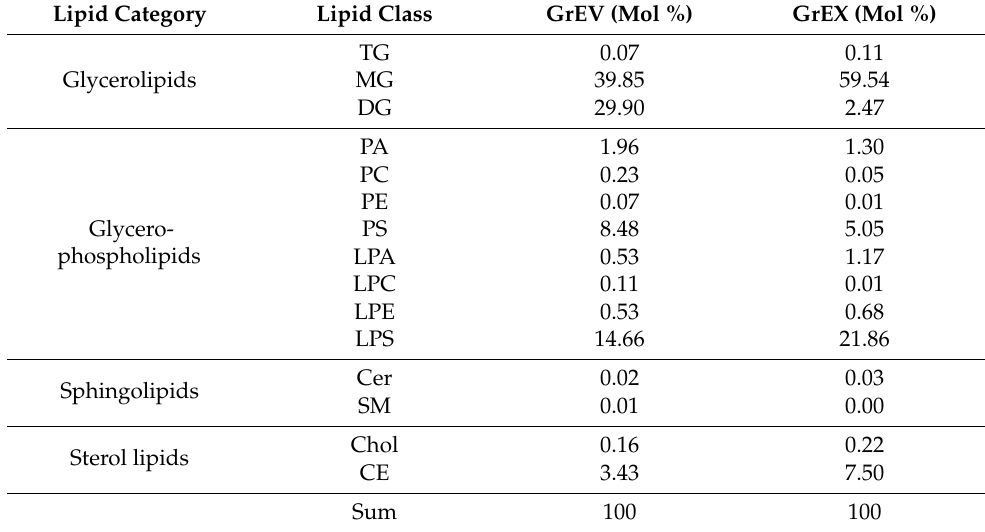
Table 3. The compositional proportions of lipid classes in GrEVs versus GrEXs. Each mol% represents the proportion of each lipid class relative to the total lipid contents, which was defined as the sum of the amount of identified lipid species determined by measuring its peak area relative to that of the corresponding internal standard (n = 9 per group; three biological replicates, each with three technical replicates). Lipid classes that increased in GrEVs or GrEXs are indicated by light or dark gray colors,